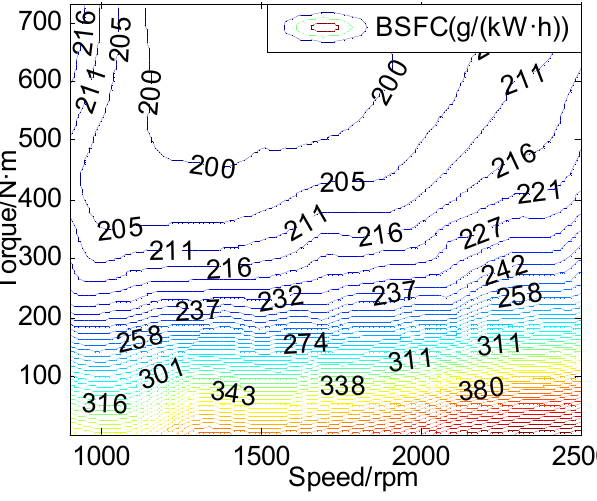
Figure 2. Brake specific fuel